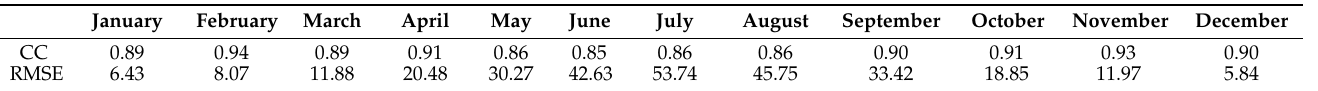
Figure 2. Density scatterplots of the monthly precipitation from CN05.1 versus ground-based observation. The black dashed line is the 1:1 line. n: number of valid samples; CC: Pearson correlation coefficient; RMSE: root-mean-square error of the monthly precipitation (mm); The color-coded dots represent the number of samples. Table 1. Statistical metrics summarizing the performance of monthly precipitation estimates relative to station observations (RMSE unit: mm/month for monthly data).